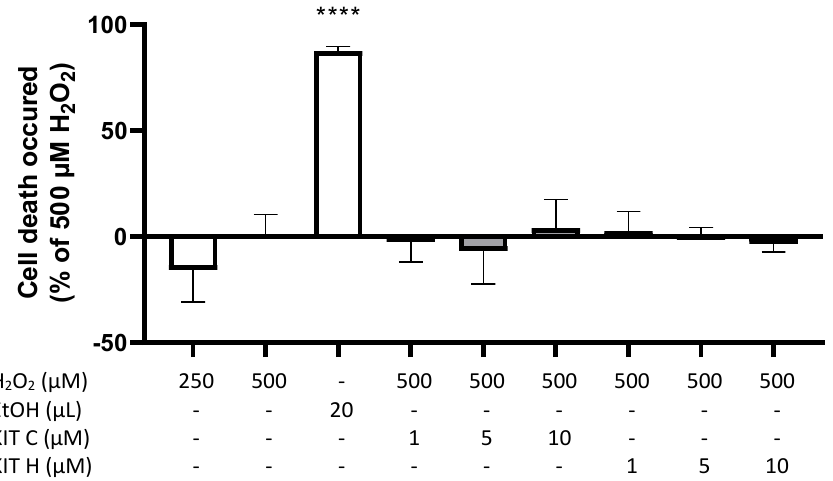
Figure 5. Effects of KIT C (light grey) and KIT H (dark grey) on H 2 O 2 -induced cell death in the ROS-MTT assay in GPR55-knockout SK-N-SH cells. SK-cells were stimulated as described in material and methods. After 24 h, cell death was measured by a change in color due to MTT-oxidation. Values are presented as the mean ± SD of at least three independent experiments. Statistical analysis was performed using one-way ANOVA with Dunnett’s post hoc tests with **** p < 0.0001 compared to 500 µM H 2 O 2 .